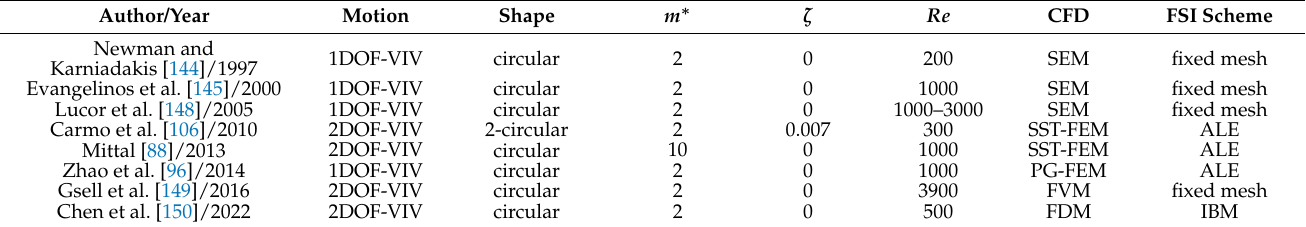
Table 2. Summary of 3D DNS of flow-induced vibration of a bluff body in the turbulent